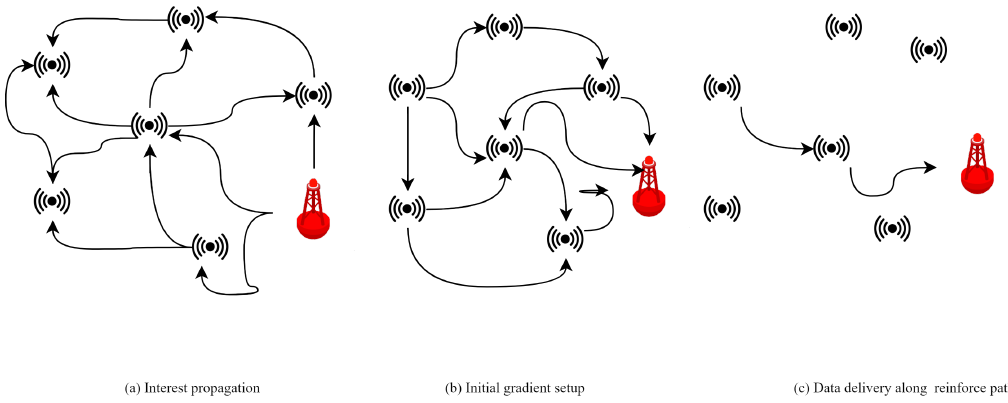
Figure 8. A simplified version of the directed diffusion protocols